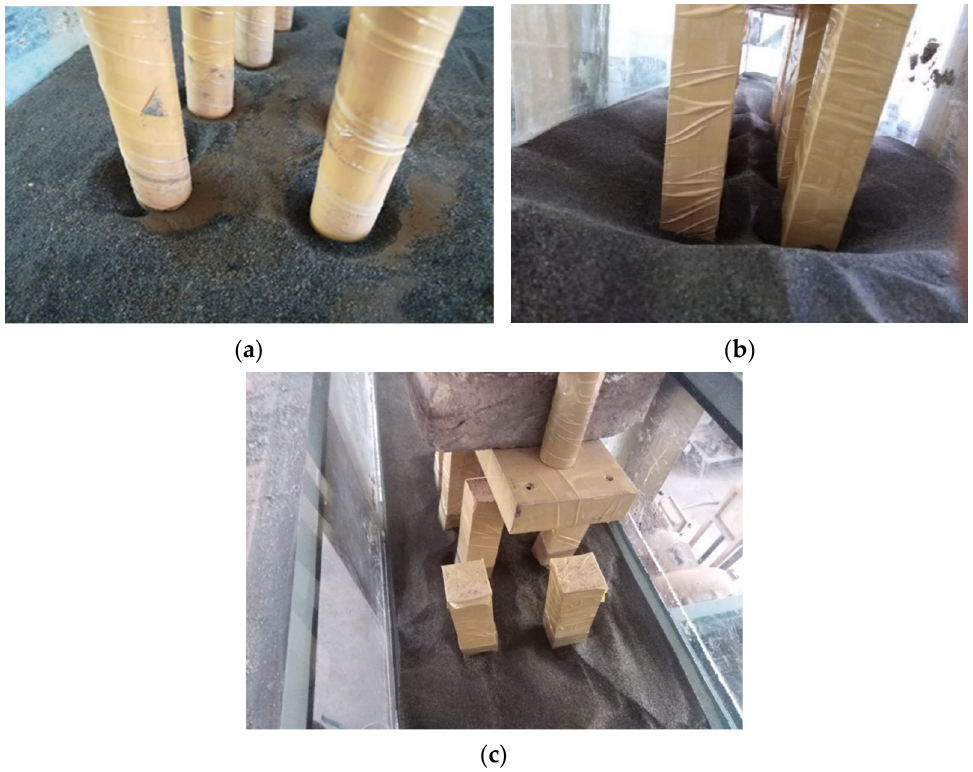
Figure 6. ( a ) Scour hole around the circular pile; ( b ) scour hole around the square piles; ( c ) disloca- tion of the pile cap due to excess loss of soil.